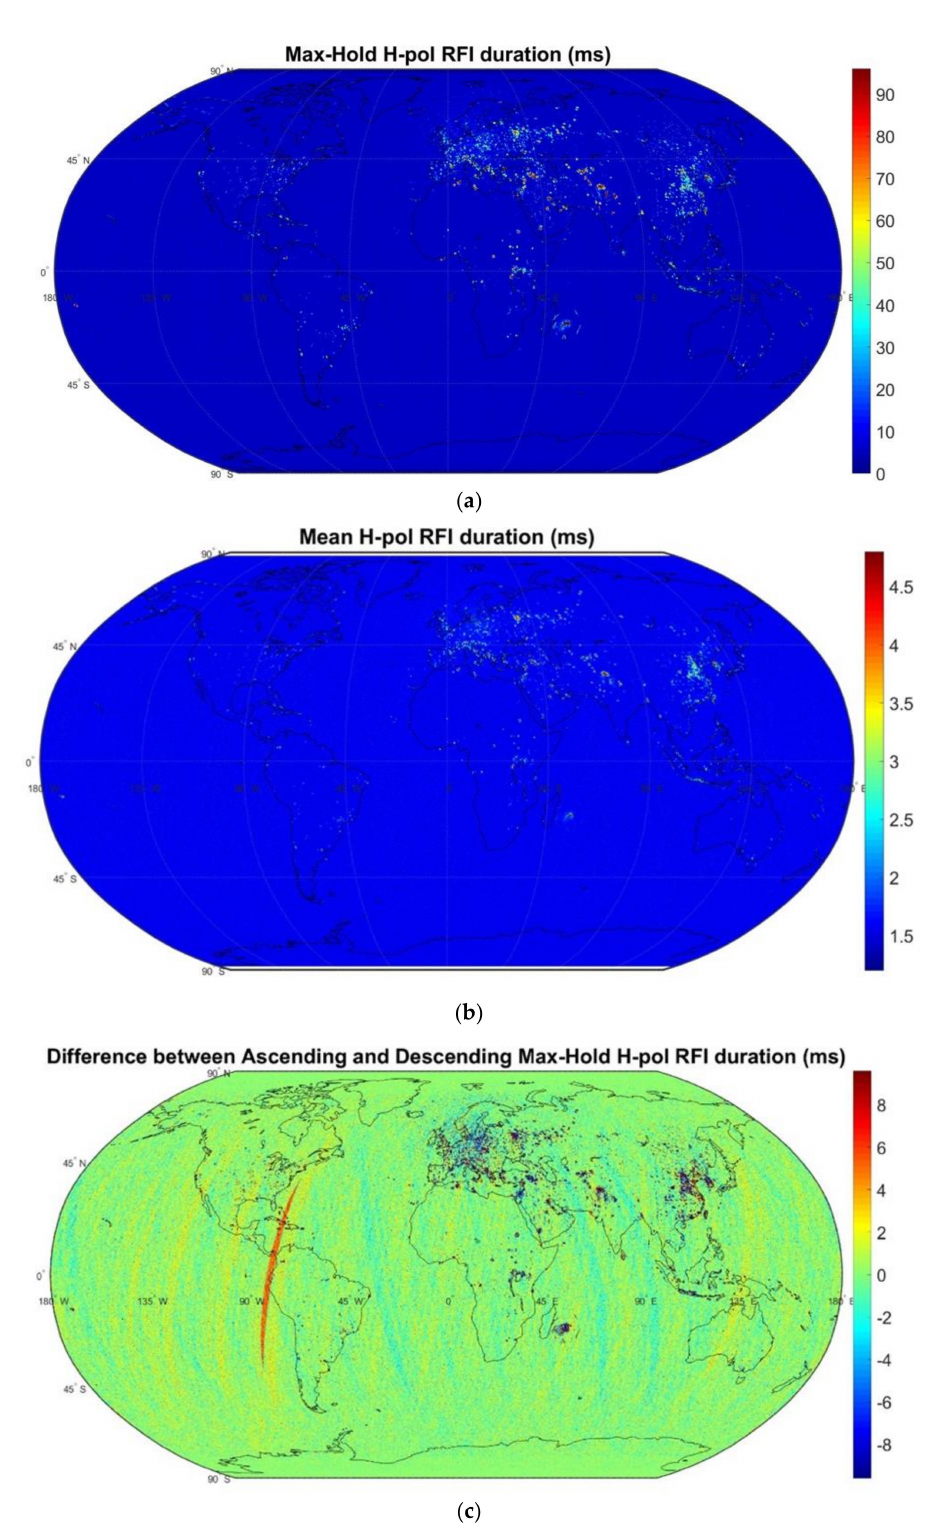
Figure 5. ( a ) Maximum RFI durations, ( b ) average RFI durations, and ( c ) difference in maximum RFI durations between ascending and descending orbits within the SMAP band in H-pol between 1 and 7 May 2019 on 0.25 ◦ × 0.25 ◦ gridded maps. The large orange region in ( c ) is due to missing data in descending